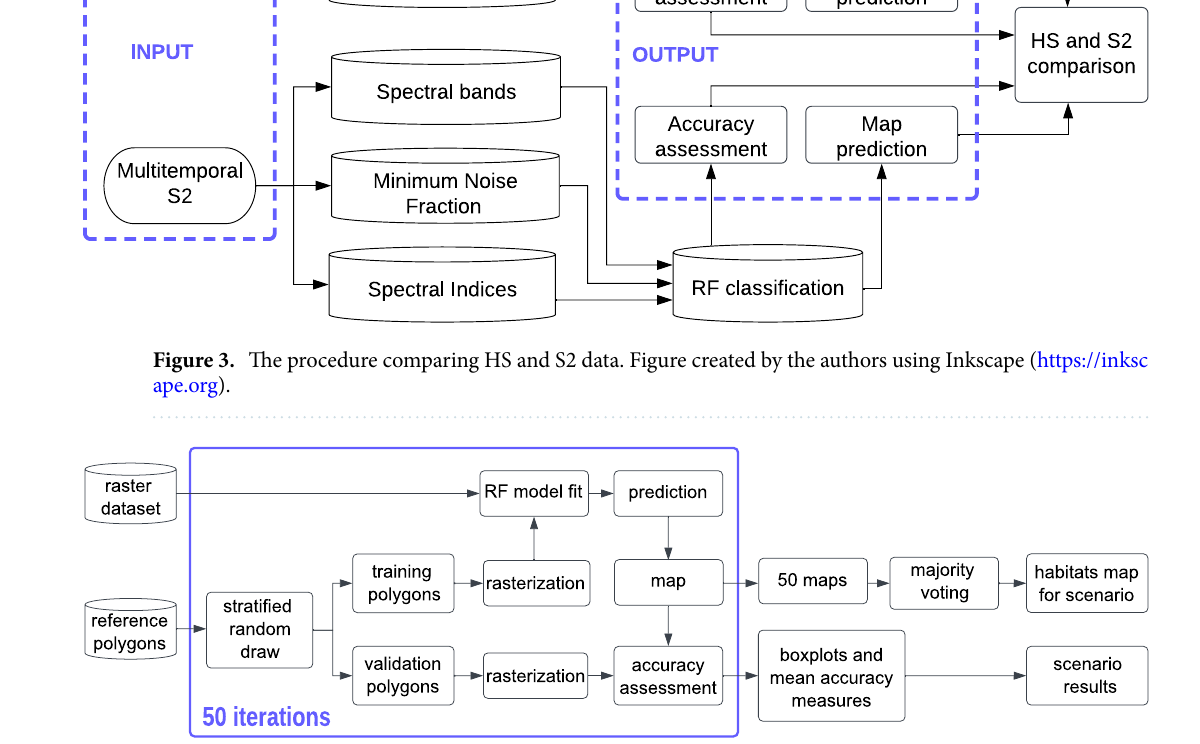
Figure 4. Map production process. Figure created by the authors using Inkscape (https:// inksc ape.